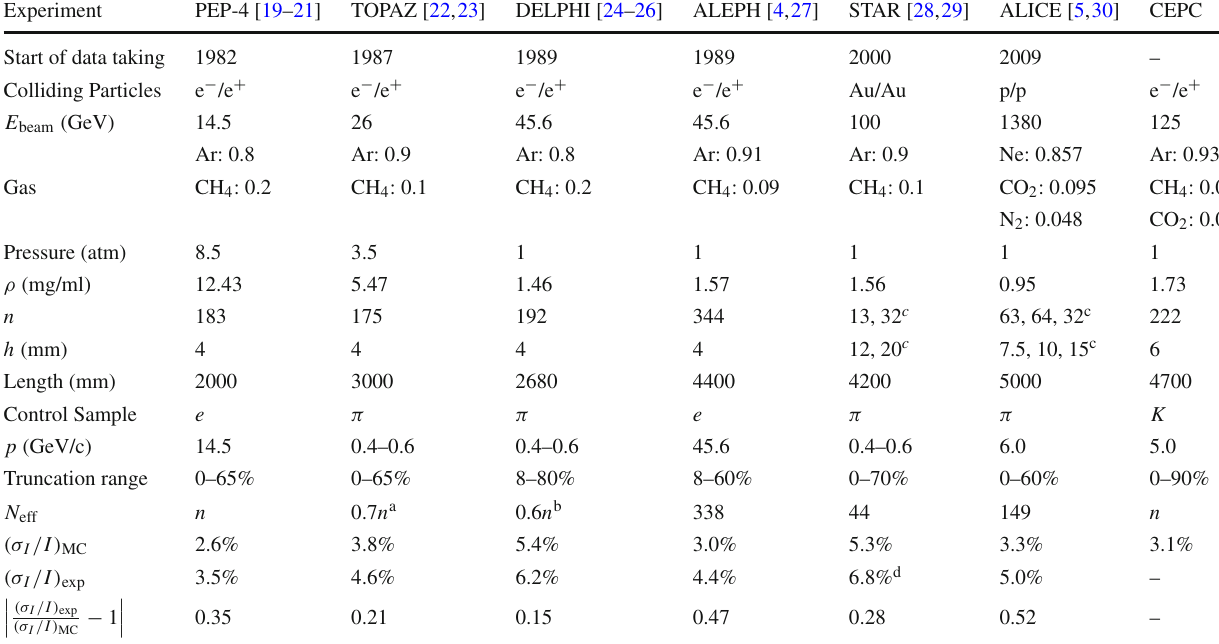
Table 1 Properties of TPCs in previous experiments. Comparison of the relative dE / dx resolution between MC and experimental measurements Experiment